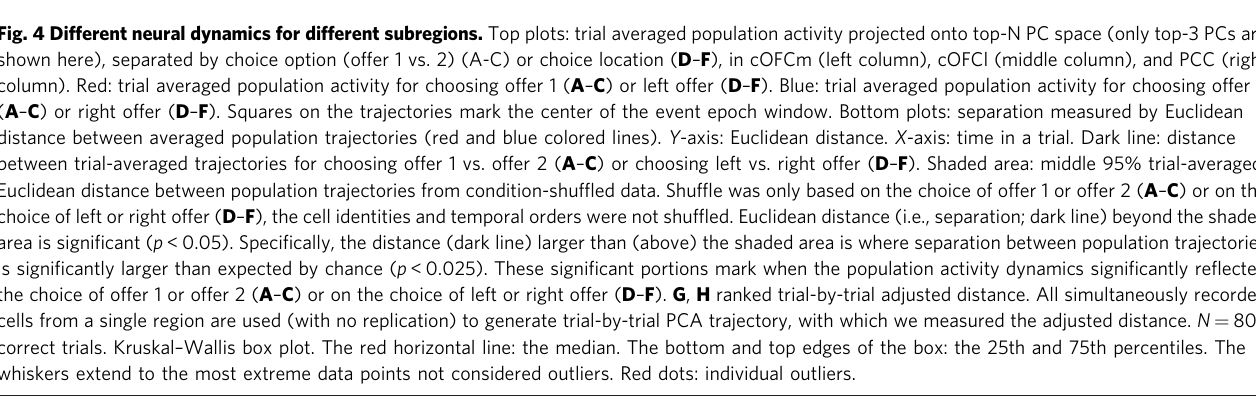
(offer 1 vs. 2) in cOFC l did not Granger-cause the distance between population trajectories for chosen location (left vs. right)